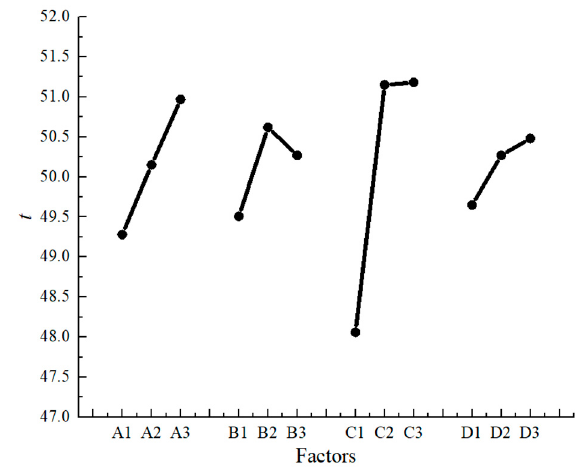
Figure 10. Range analysis diagram.